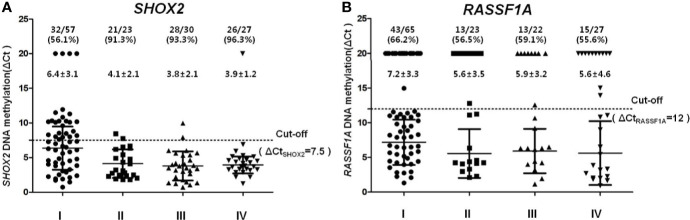
Quantitative analysis of SHOX2
(A) and RASSF1A
(B) DNA methylation in different tumor stage groups (A). SHOX2 and (B)
RASSF1A DNA methylation values measured in different tumor stage, I (dots), II (squares), III (up-triangles), IV (down-triangles).